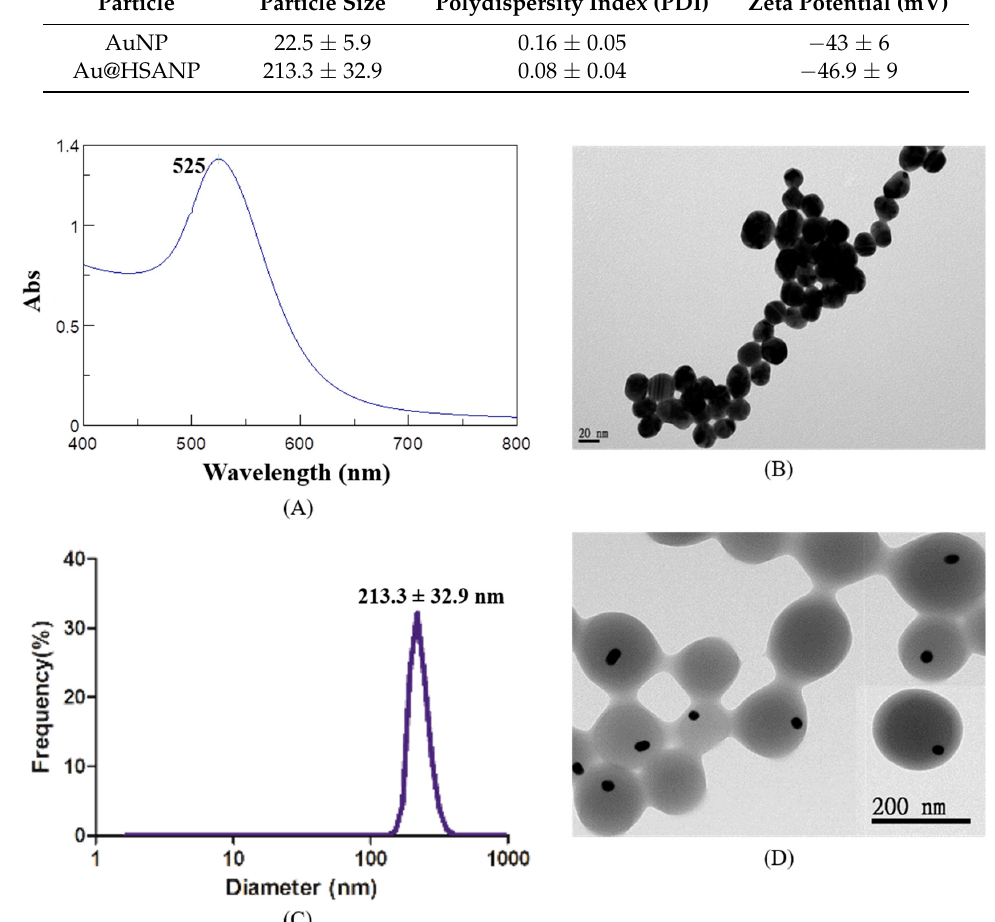
Table 1. Average particle size of AuNPs and Au@HSANPs determined by dynamic light scattering (DLS). Particle Size